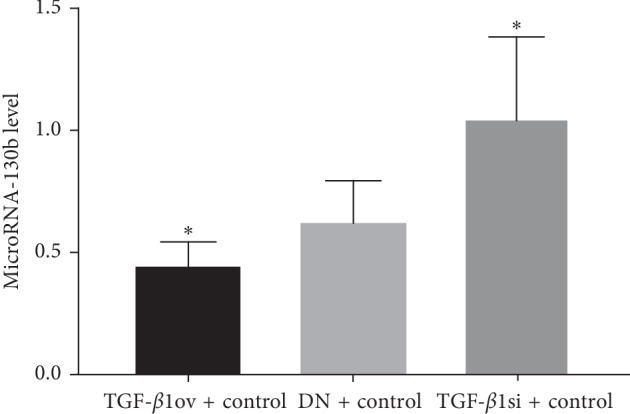
MicroRNA-130b expression. TGF-β1ov + control, TGF-β1 overexpression + oil; TGF-β1si + control, TGF-β1 siRNA + oil; DN + control, DN + oil. ∗p < 0.05 vs DN + control.